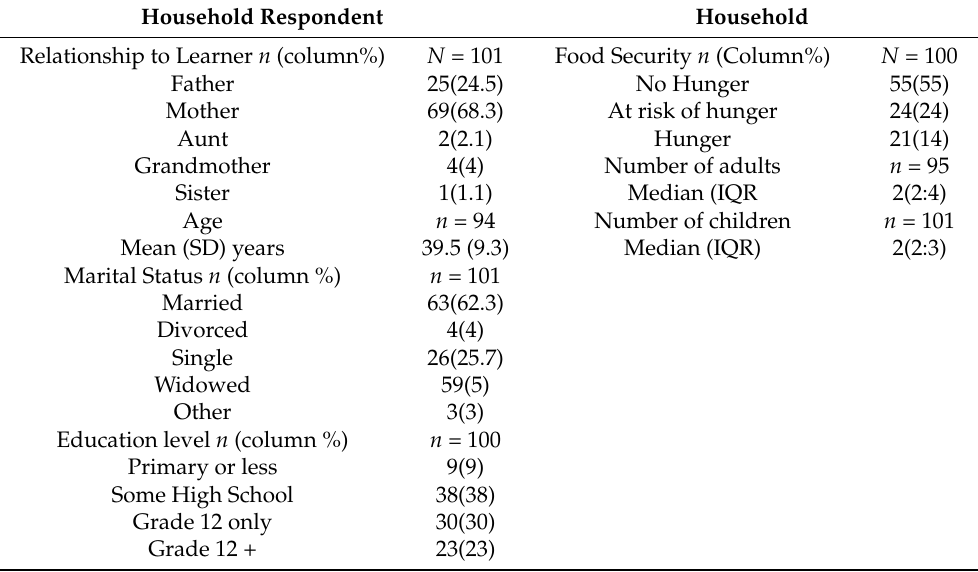
Table 1. Socio-demographic profile of household respondents and